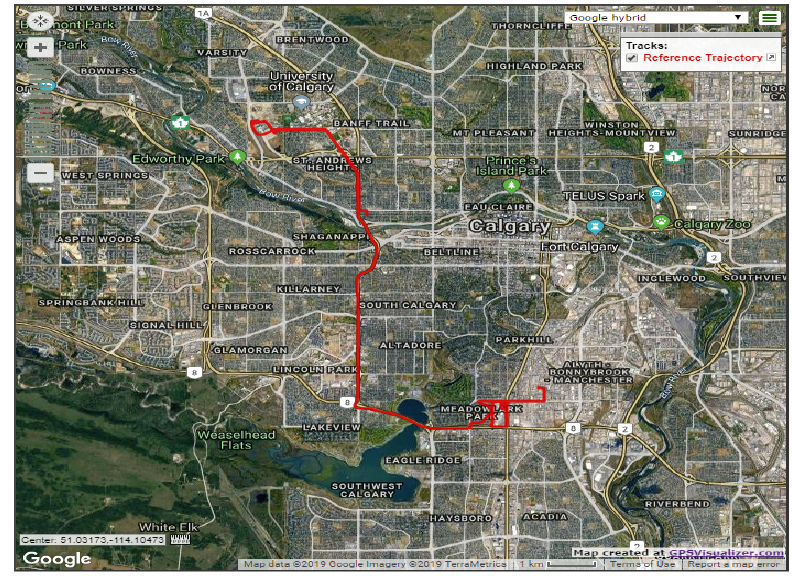
Figure 8. The second test trajectory for SF-PPP/INS integration, Calgary, Alberta, Canada.